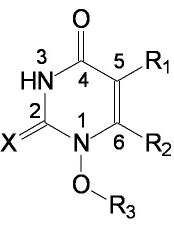
Figure 3. The envisaged positions for substituents of the uracyl